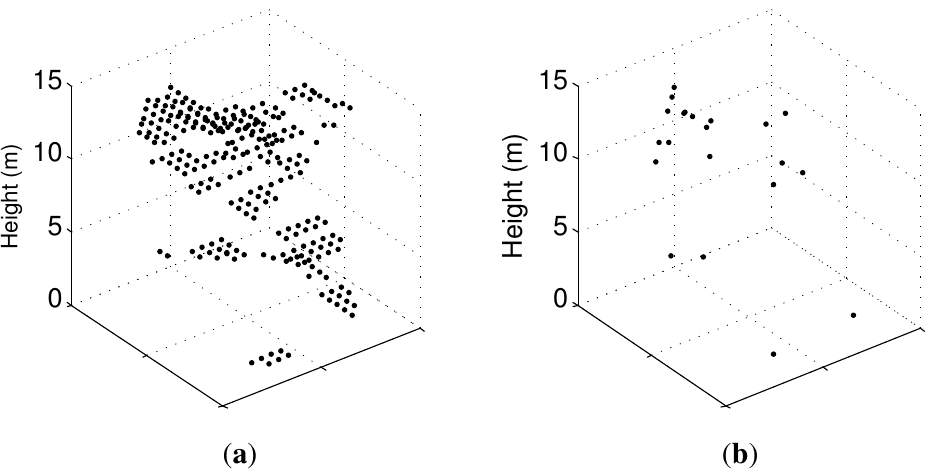
Figure 10. Removing duplicates from gap height values: ( a ) before duplicates are removed; ( b ) after removing duplicates. Horizontal axes represent easting and